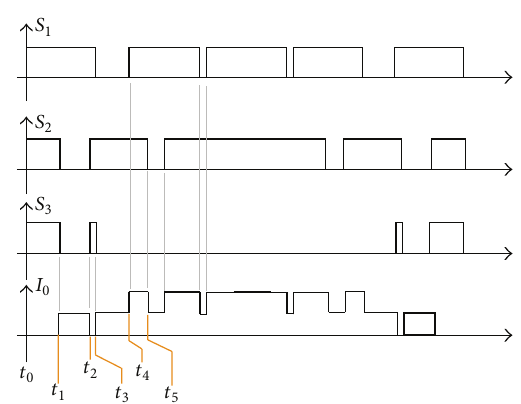
Figure 4: Control signals and output current. Top to down: control signal of 𝑆 1 , control signal of 𝑆 3 , control signal of 𝑆 2 , and output